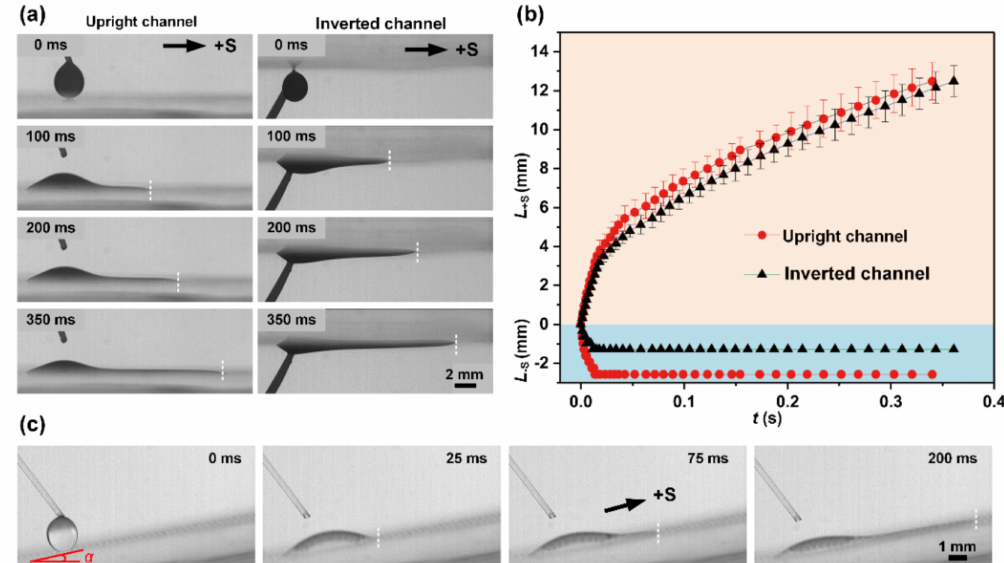
Figure 7. ( a ) Time-lapse images of liquid transport process on upward and downward channels. ( b ) Relative transport distance versus time for liquid spreading on the channels. ( c ) Spontaneous antigravity unidirectional liquid transport on the